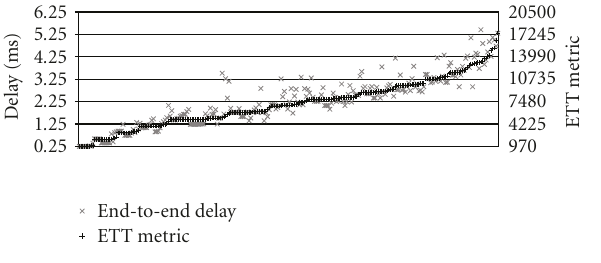
Figure 14: Comparison of ETT metric and end-to-end delay variations ( f 6).